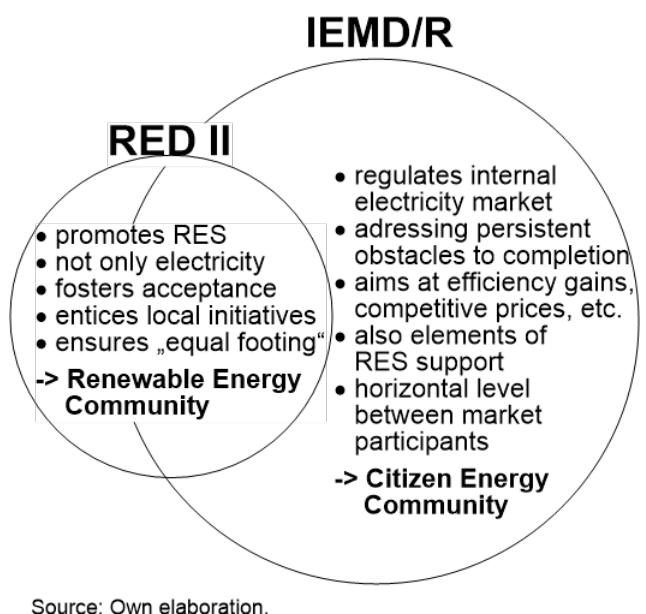
Figure 1. Relation of the Renewable Energy Directive (RED II) and the Internal Electricity Market Directive/Regulation (IEMD/R).